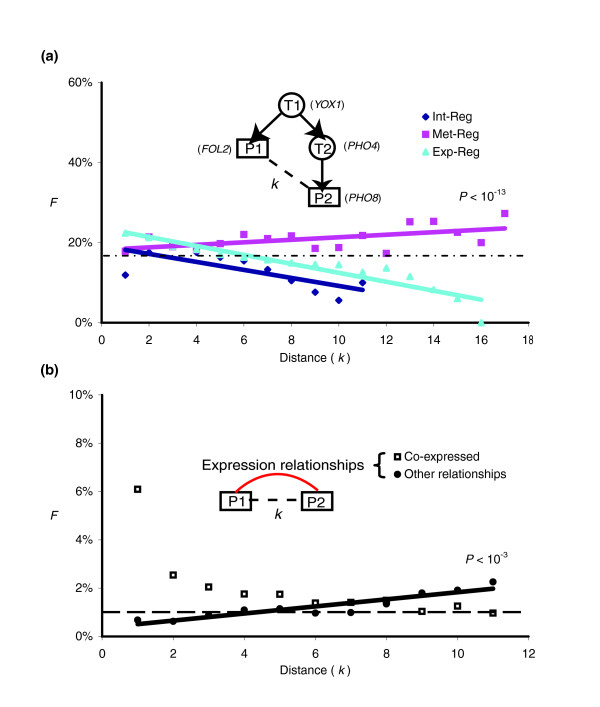
Fraction (F) of all P1-P2 pairs at distance k in a given combined network in a particular composite motif. Horizontal dashed lines indicate the random expectation. (a) Bridges. The schematic shows that a bridge consists of four proteins: T1 regulates T2 and P1; T2 regulates P2. For example, Fol2p and Pho8p are two subsequent enzymes involved in the folate biosynthesis pathway [7]. FOL2 is regulated by Yox1p [9]. PHO8 is regulated by Pho4p [56]. Yox1p also regulates PHO4 [9]. The P value in the figure indicates the significance of the different between the fraction of bridges between all disconnected enzyme pairs and the random expectation (Table 3 in Additional data file 1). The regression equation for Met-Reg: F = 0.003k + 0.18; R = 0.56; P < 0.01. The regression equation for Int-Reg: F = -0.01k + 0.19; R = 0.74; P < 10-3. The regression equation for Exp-Reg: F = -0.01k + 0.24; R = 0.93; P < 10-9. P values here measure the significance of the correlation (R) in regression. (b) Composite motifs in the combined network of Met-Exp (that is co-expression motifs and shifted motifs). The schematic shows that composite motifs in Met-Exp consist of two proteins: P1 and P2. P1 and P2 have a distance of k in the metabolic network. They also have an expression relationship (co-expressed or others) in the co-expression network. The P value indicates that the fraction of protein pairs in shifted motifs in Met-Exp is significantly higher than expected. The regression equation for Met-Exp: F = 0.002k + 0.0037; R = 0.92; P < 10-8. Met, the metabolic network; Int, the interaction network; Exp, the co-expression network; and Reg, the regulatory network.